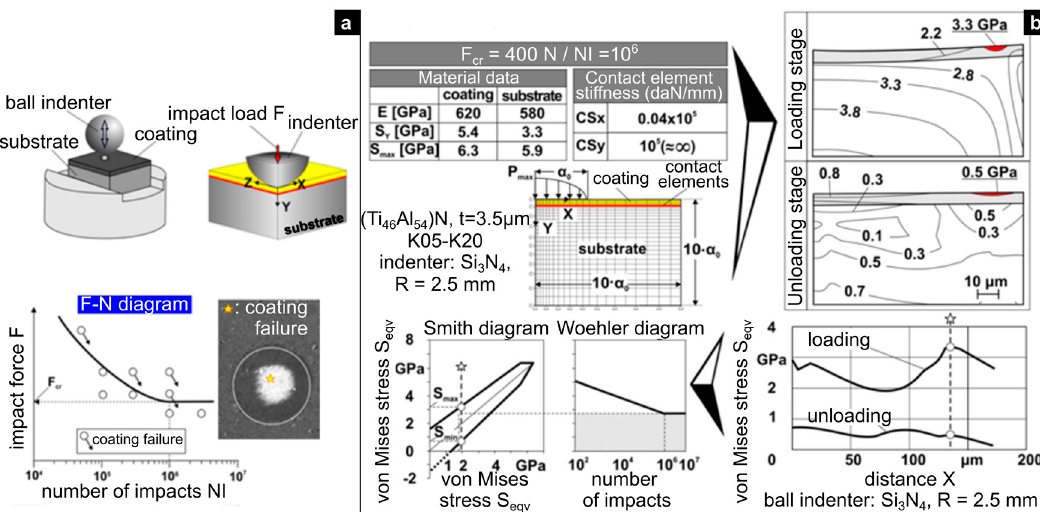
Figure 2. ( a ) Impact test procedure; ( b ) determination of the fatigue critical impact force and construction of coating’s Smith- and Wöhler-like diagrams.